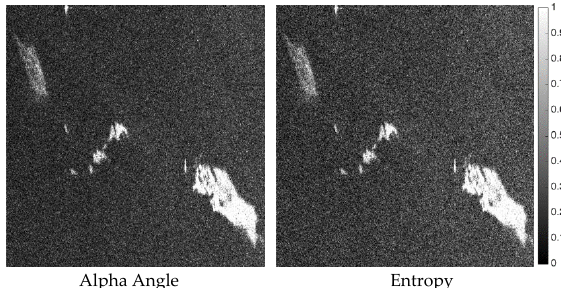
Figure 3. Quad-pol features extracted from the RASARSAT-2 data.